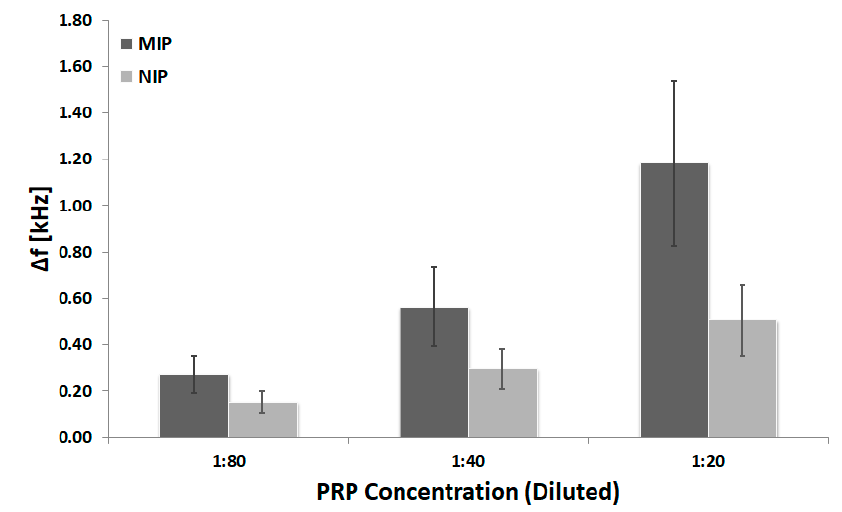
Figure 3. PRP different dilutions vs. corresponding binding response on QCM MIP-NIP electrodes ( n = 6). x -axis represents different thrombocytes dilutions (1:80 = 2.5 × 10 4 thrombocytes/µL, 1:40 = 5 × 10 4 thrombocytes/µL and 1:20 = 10 5 thrombocytes/µL), y-axis represents the binding response on the gold electrode surface on the MIP and NIP sides respectively.